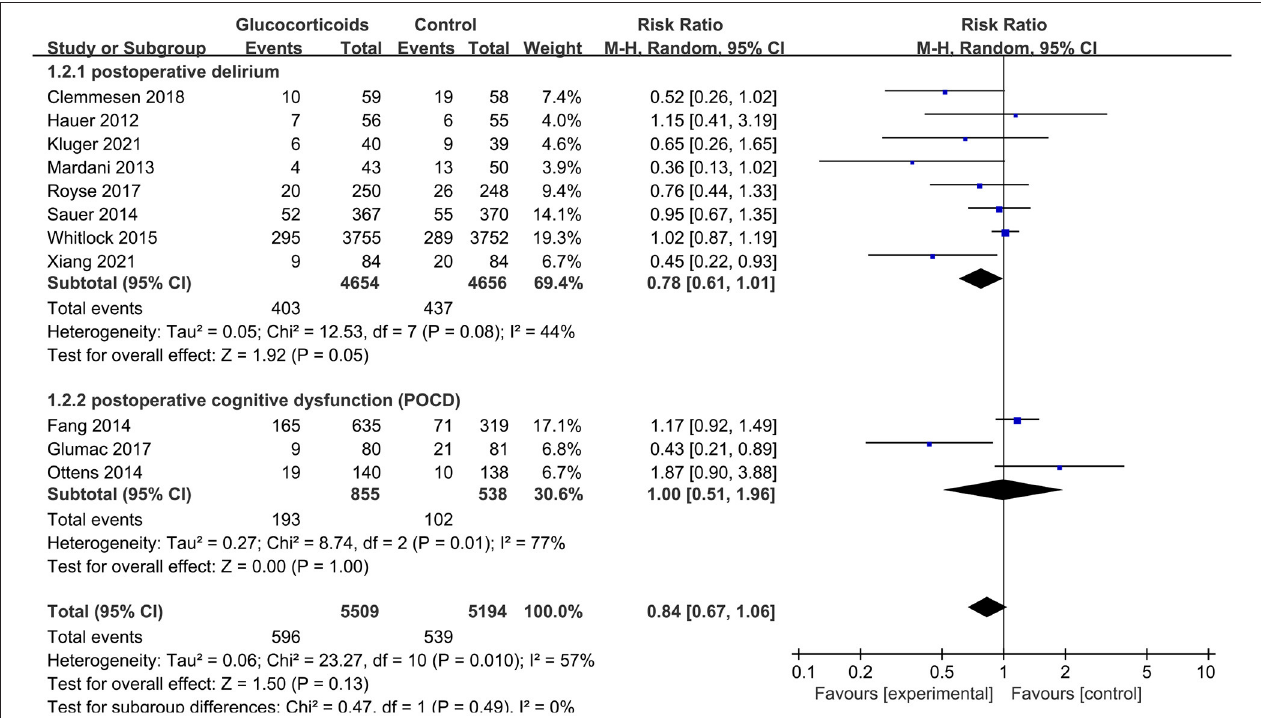
FIGURE 5 | Subgroup analysis of the incidence of PNDs for the type of